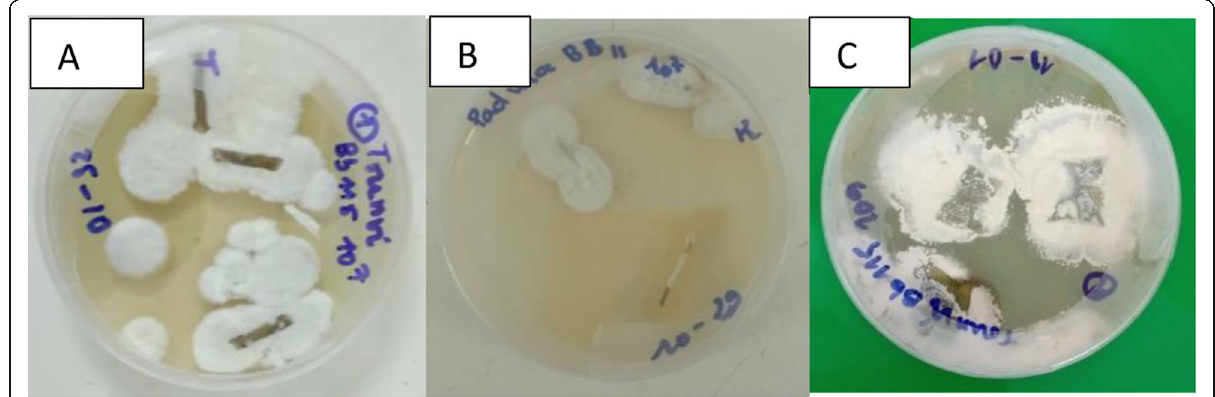
Fig. 1 Colonization of different tomato stem ( a ), root ( b ), and leaf ( c ) segments by Beauveria bassiana after microscopic